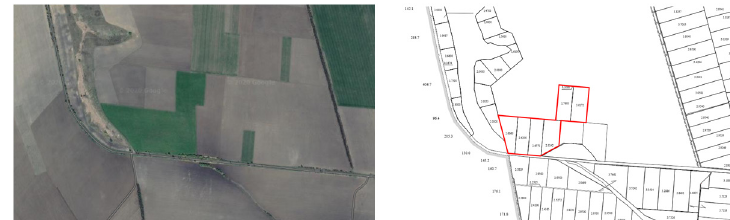
Figure 4. Land plots placement and usage within the eleventh land mass (source: https://map.land.gov.ua/)